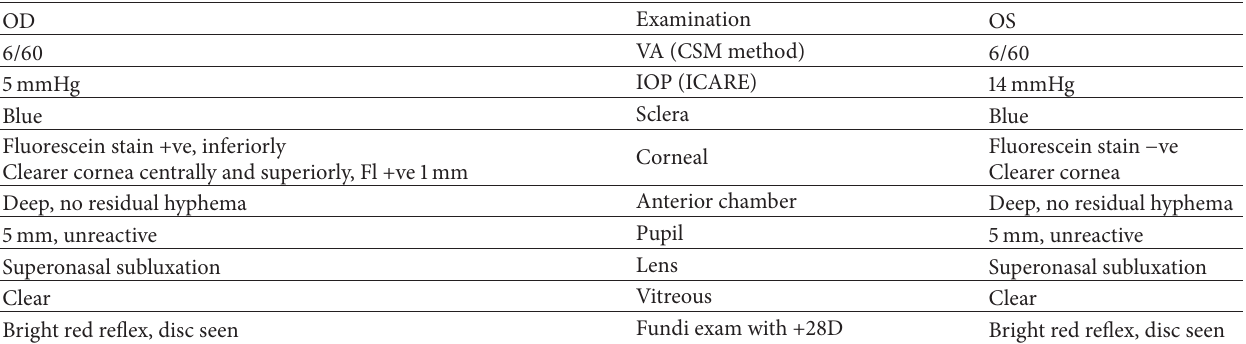
Table 2: First Postoperative day (24 hours after surgery). Initial eye drops of Gutt Tetracaine instilled × 3 to prepare the eye for examination. The child was examined in the children’s eye ward.